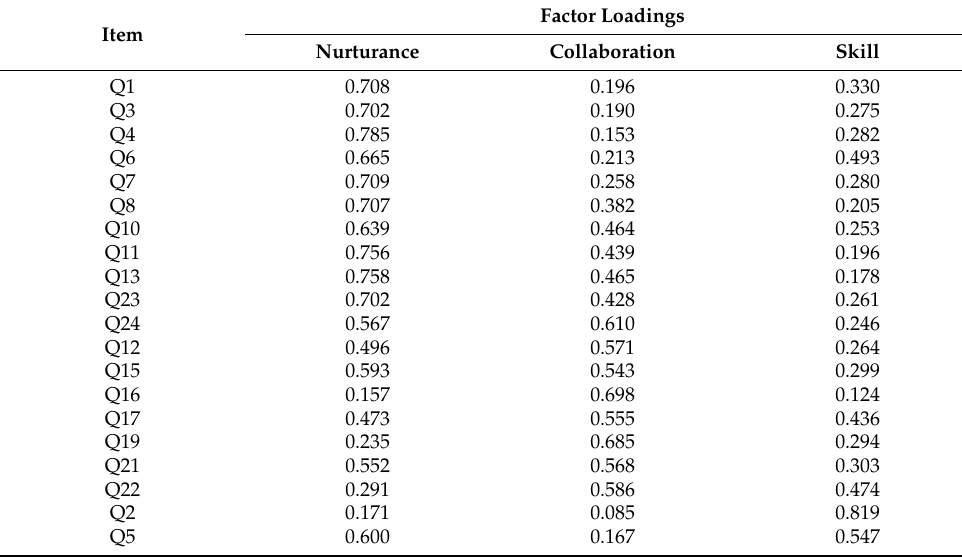
Table 3. The factor loadings of the CDI in